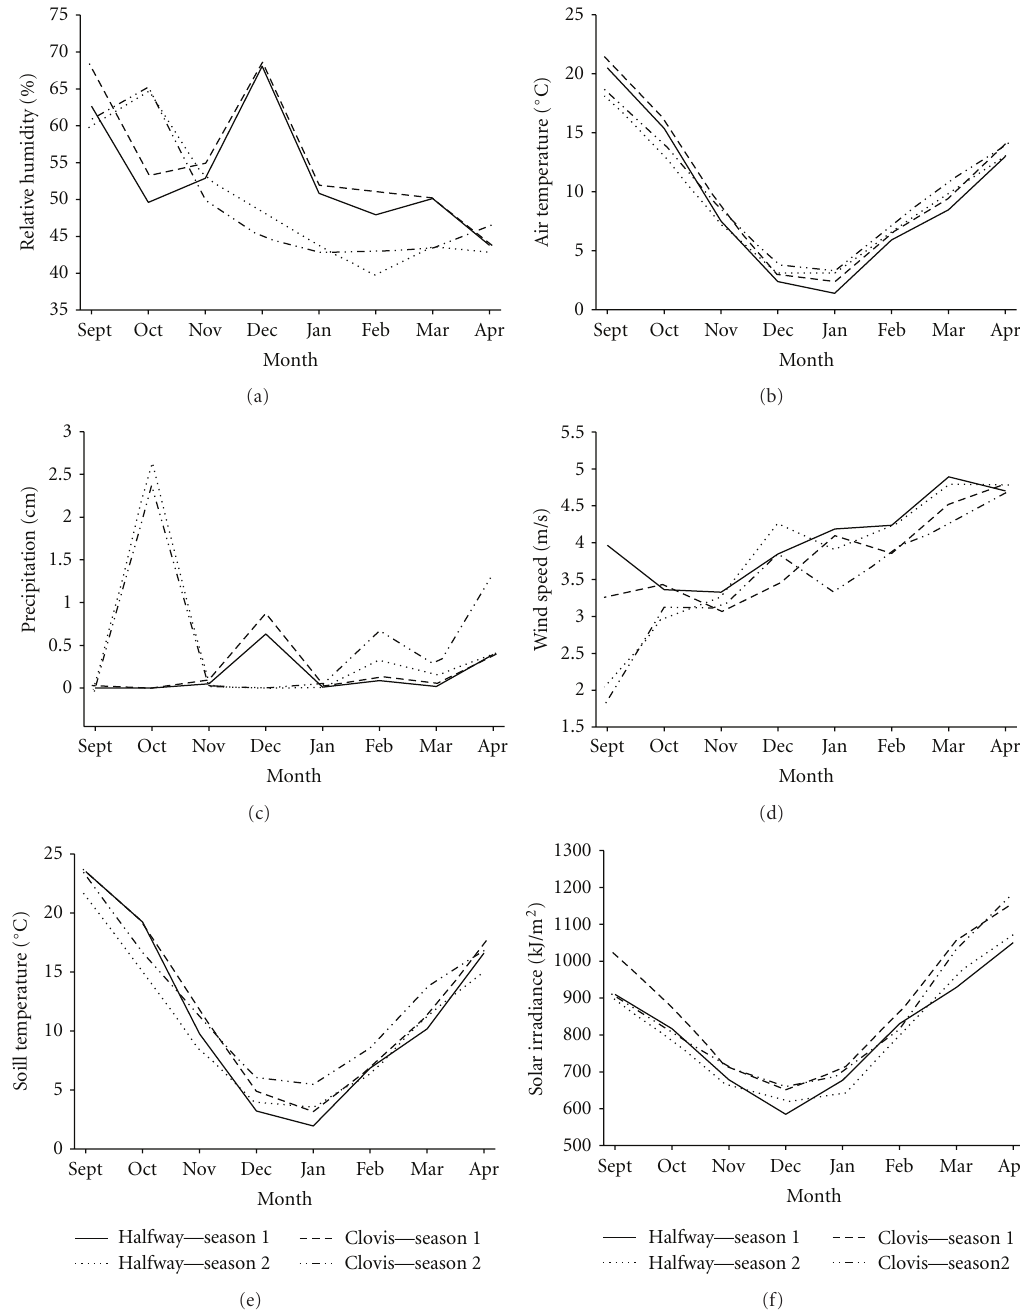
Figure 2: Abiotic conditions at two field locations (Clovis and Halfway) during two growing seasons (2007-2008 and 2008-2009).